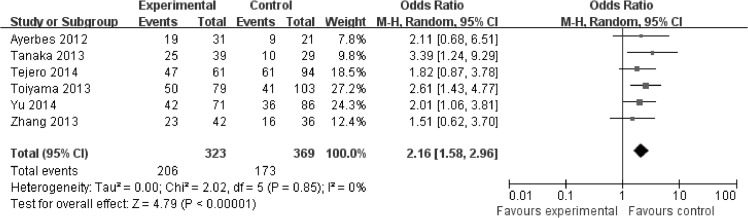
Meta-analysis evaluating miR-200c expression and TNM stage for blood samples.